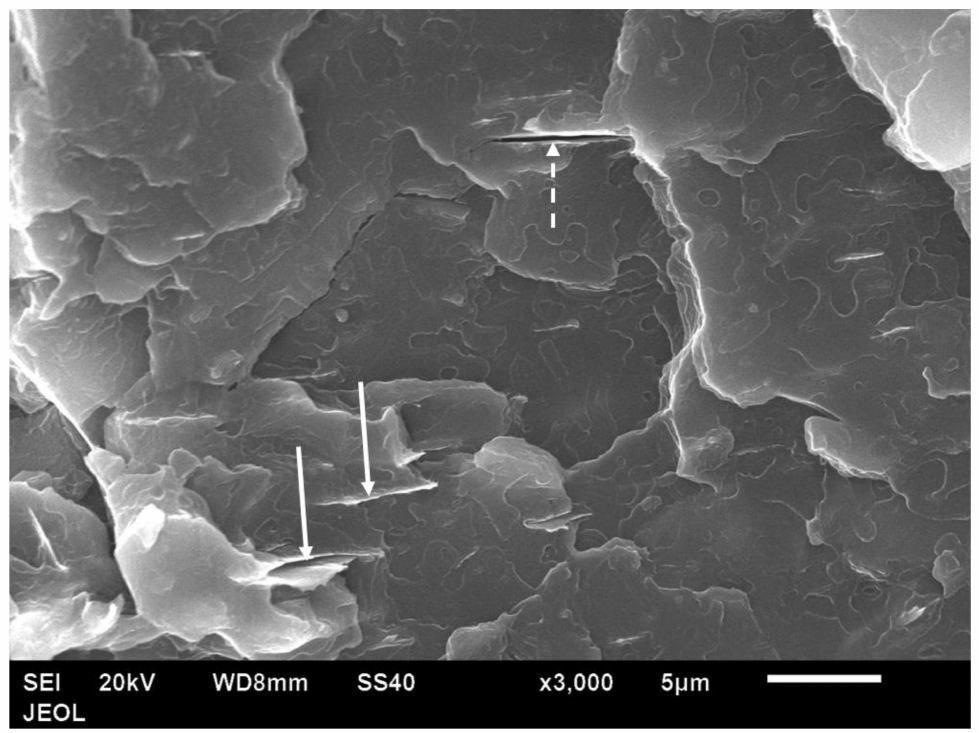
Figure 14. Fracture surface of 5 vol.% Al nano platelet–amorphous PET bar. Platelets were observed only edgewise. Downwards arrows indicate Al flakes with PET adhered to them. Upwards dotted arrow indicates a platelet with debonding on one face.